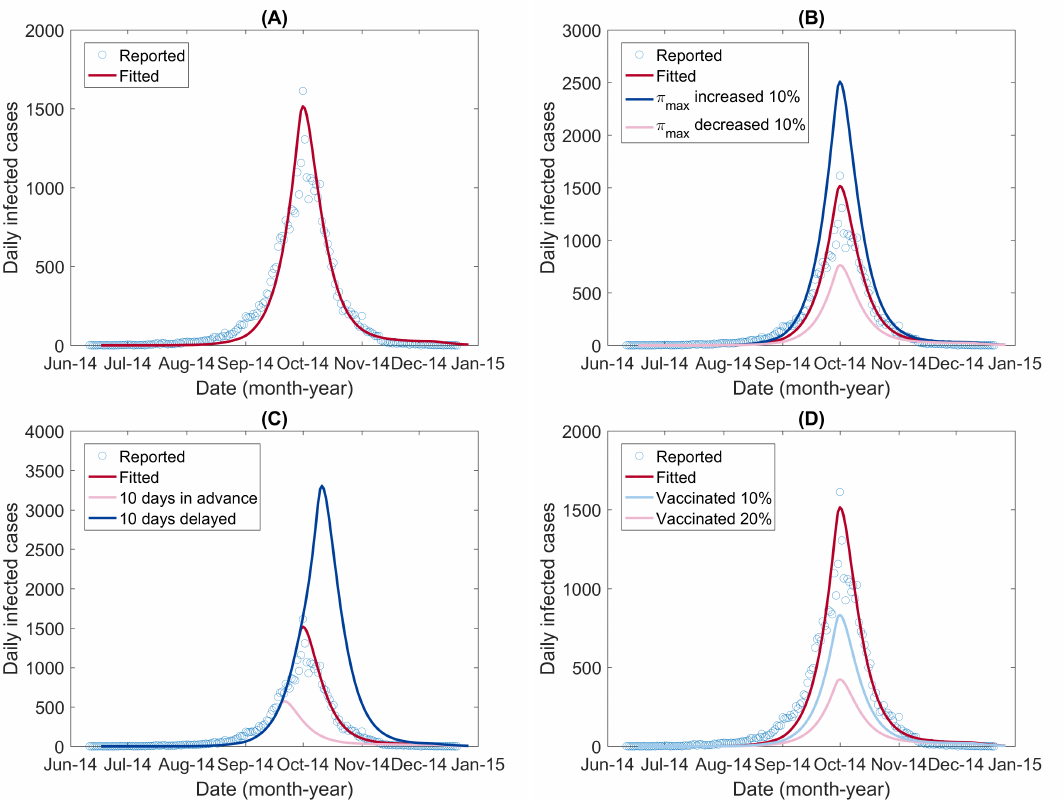
Figure 7. The epidemic curves fitted and simulated for DF in different scenarios. ( A ) the daily new DF cases in Guangzhou, 2014, and the fitted epidemic curve by the extended model; ( B ) simulated epidemic curves assuming that the carrying capacity for immature mosquitoes ( π max ) was increased or decreased by 10%; ( C ) simulated epidemic curves assuming that the interventions were taken ahead or delayed by 10 days; and ( D ) simulated epidemic curves assuming that 10% or 20% of the population had been vaccinated and were immune to